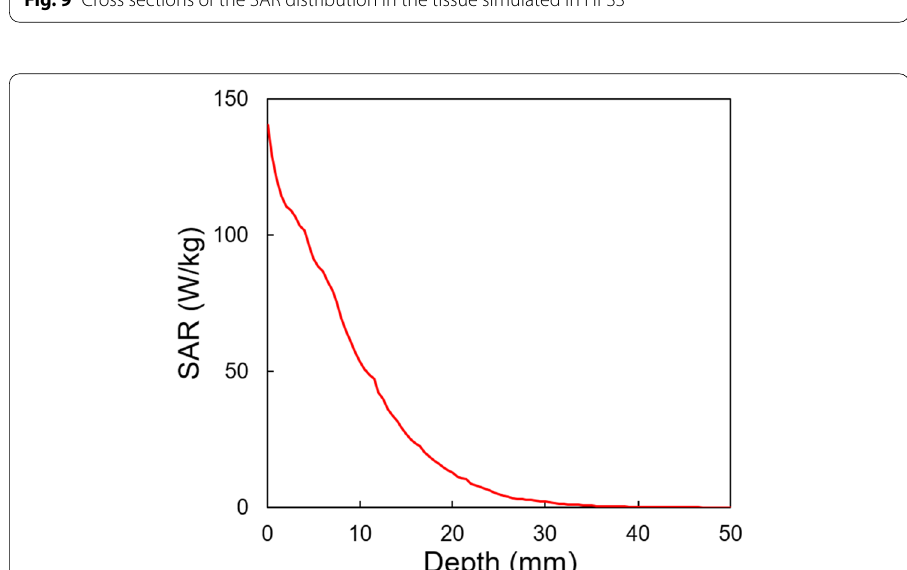
Fig. 10 Simulated SAR plotted as a function of the tissue